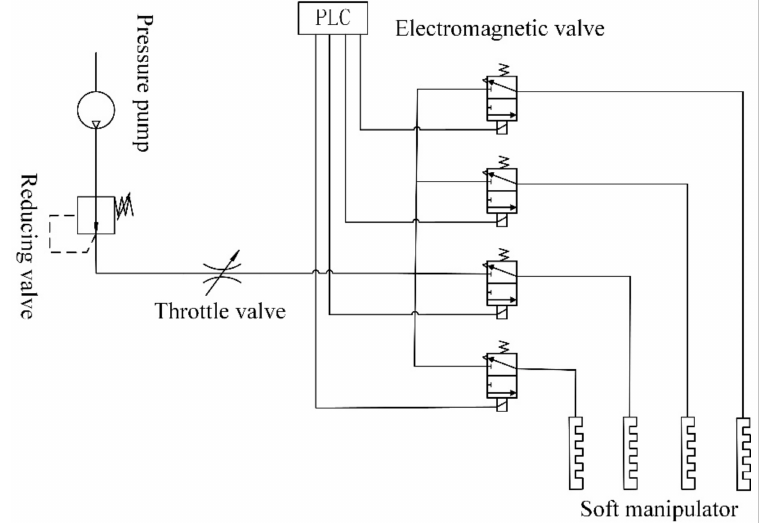
Figure 10. The schematic diagram of experimental ventilation pressure system.